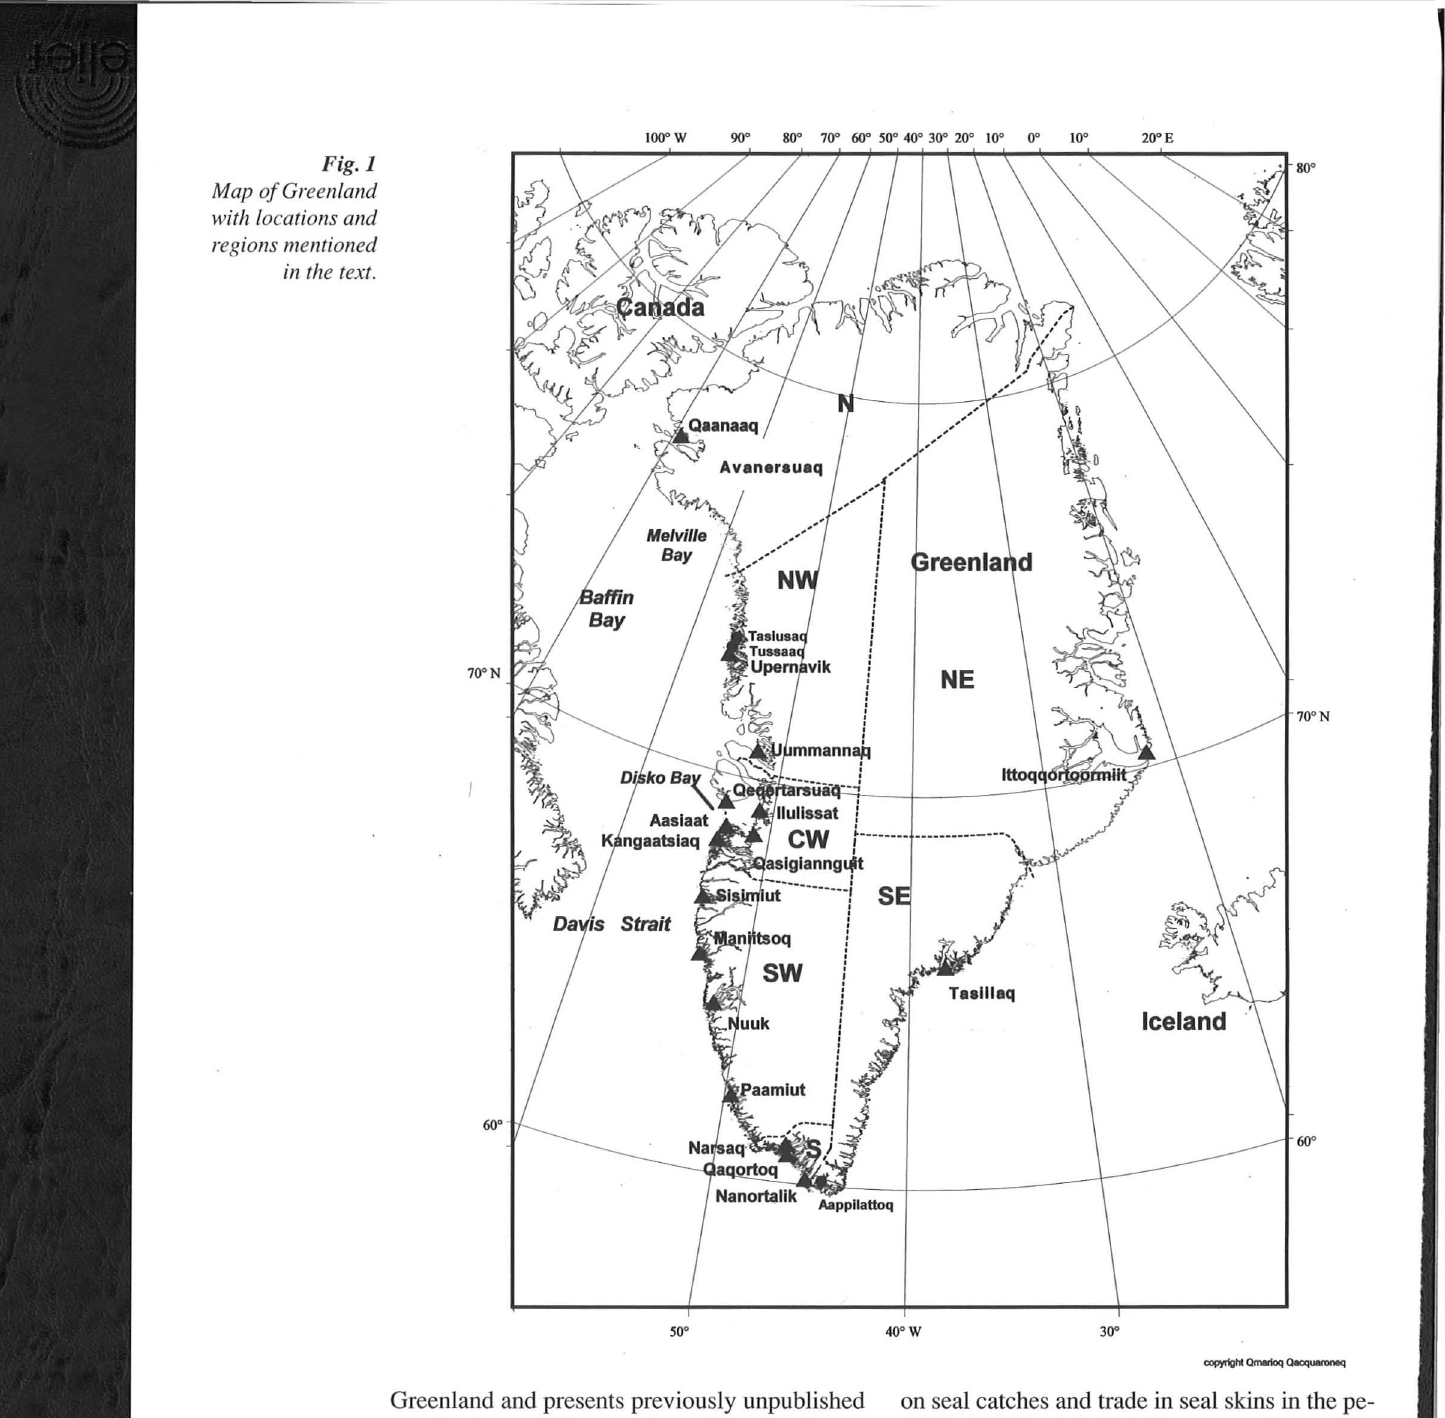
Map of Greenland with locations and regions mentioned in the